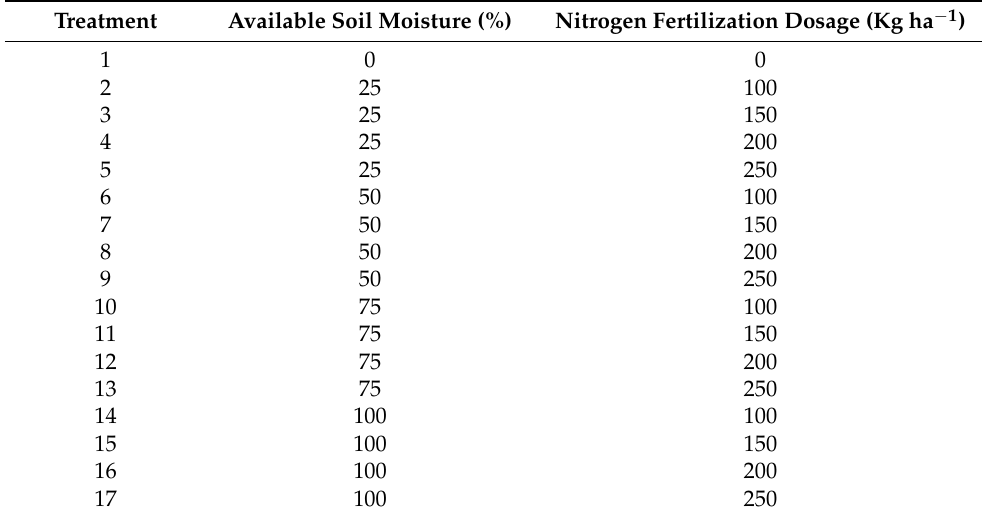
Table 2. Description of treatments of nitrogen fertilization and soil moisture in onion cultivation.